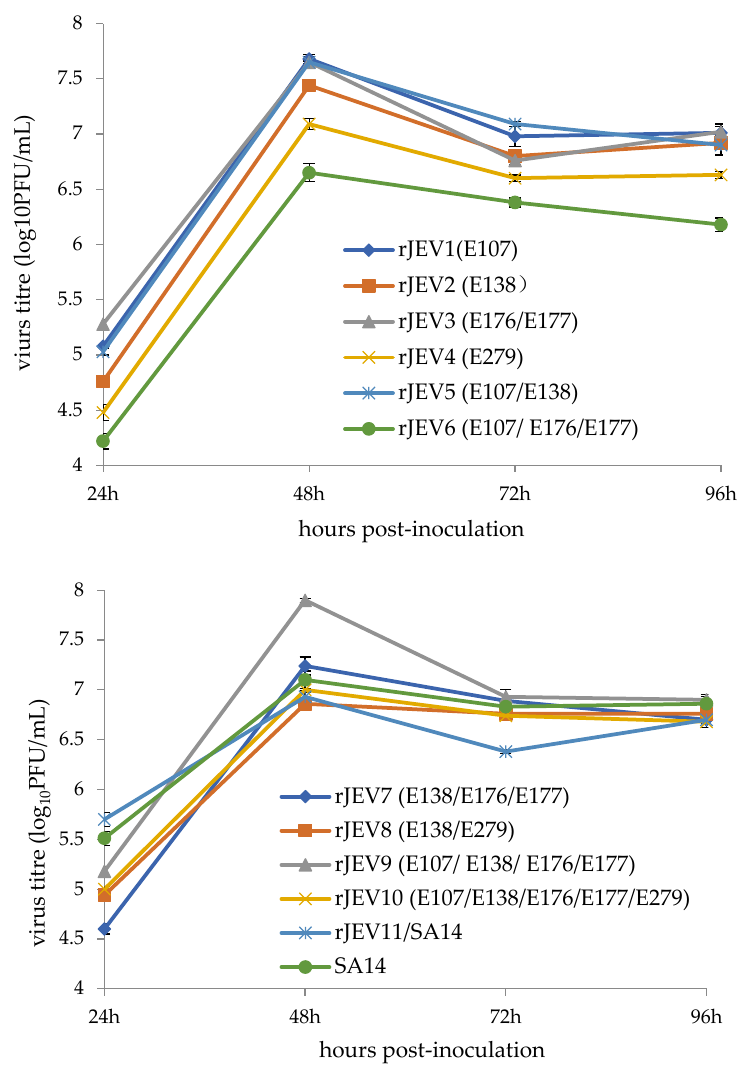
Figure 1. Growth curves of the revertants and the control viruses.